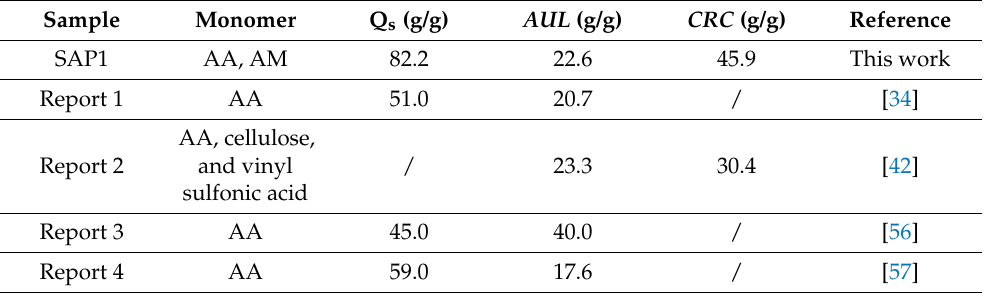
Table 2. Comparison of absorption performance of SAP1 in this study with reported works on surface cross-linking